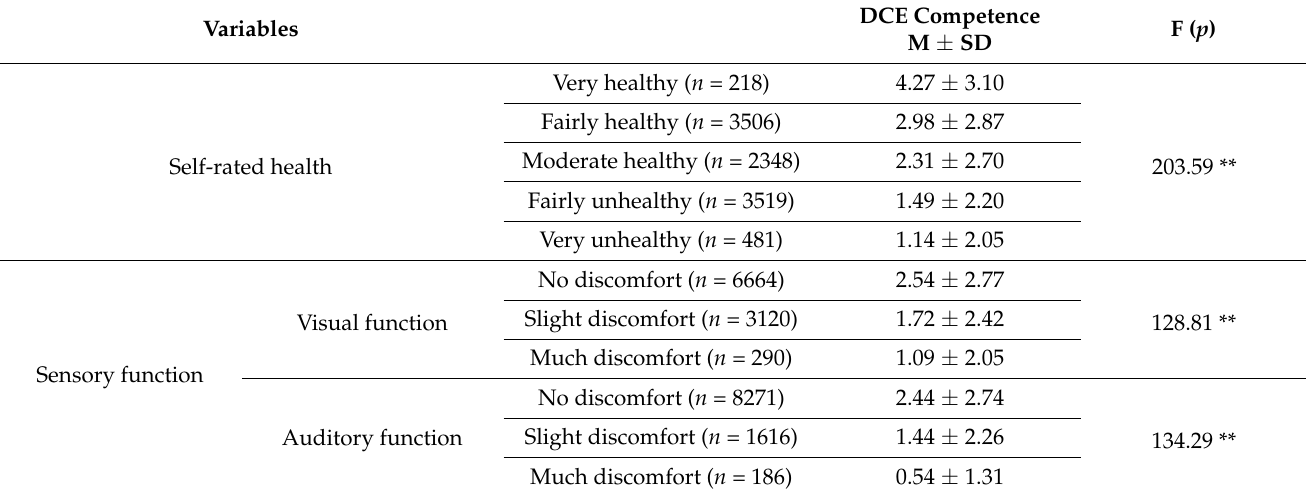
Table 3. DCE competence based on self-rated health and sensory function ( n = 10,073). Variables